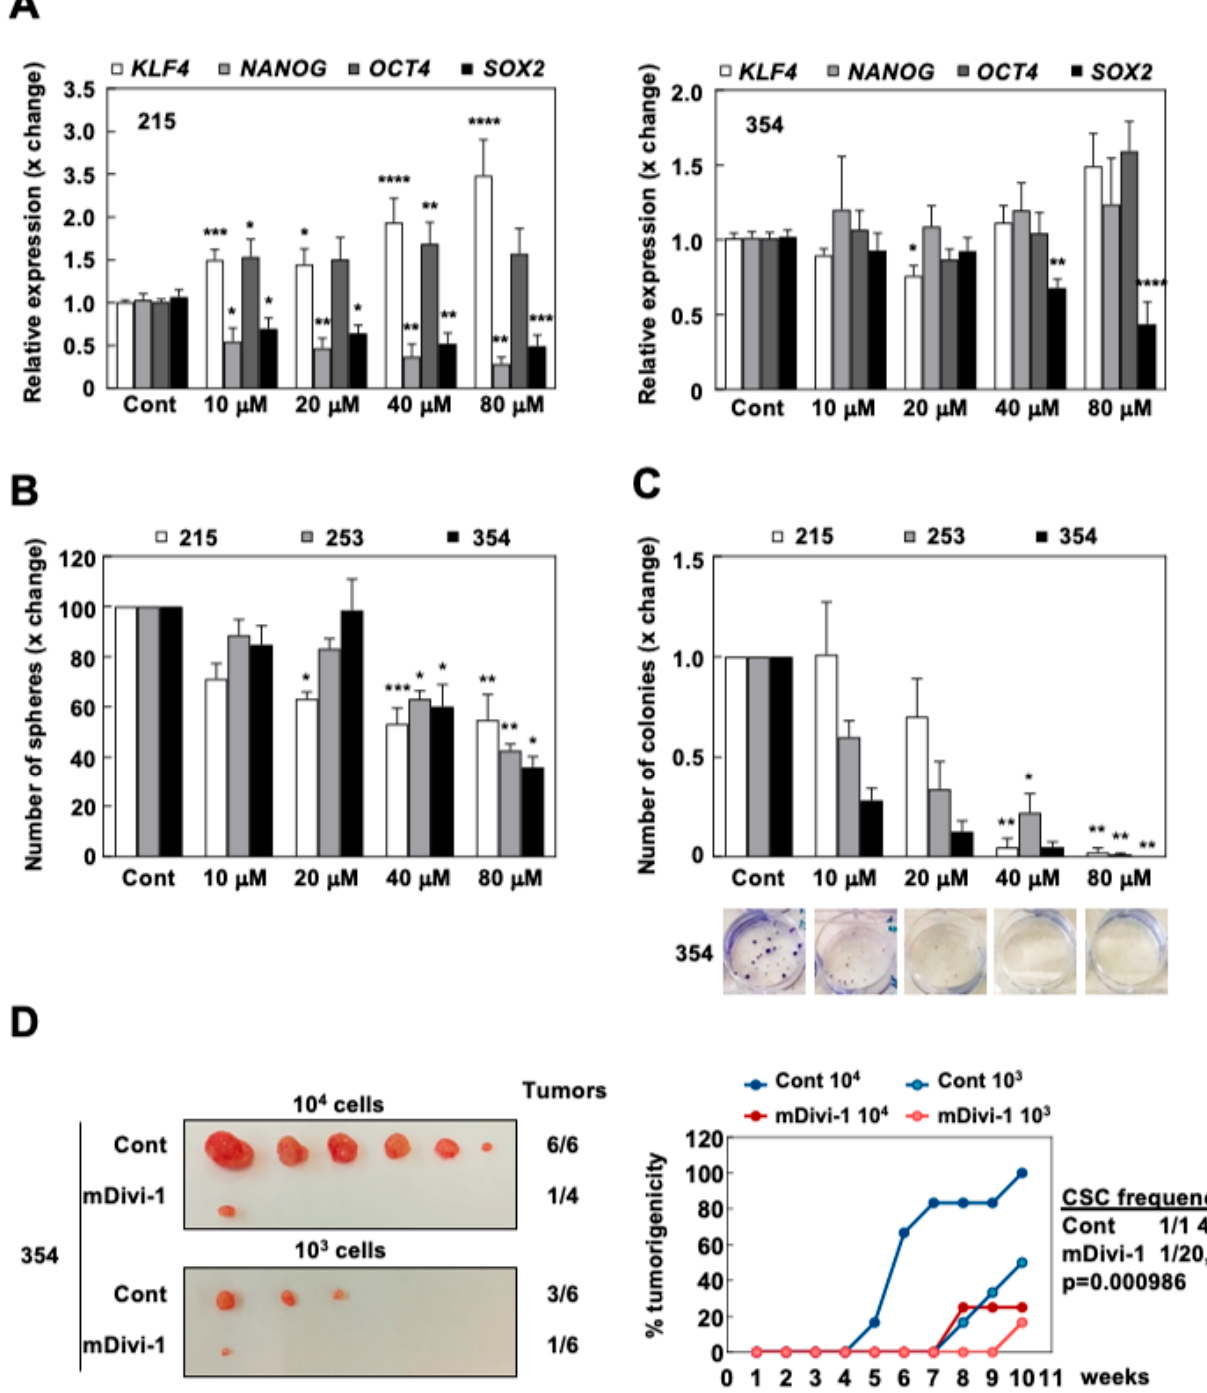
Figure 5. mDivi-1 treatment inhibits self-renewal and in vivo tumorigenicity. ( A ) Relative pluripotency genes expression in 215 and 354 cells treated with 40 µ M mDivi-1 for 72 h ( n = 5–7). ( B ) Number of spheres formed after seven days with or without mDivi-1 treatment ( n = 2–6). ( C ) Colony formation during 21 days with or without mDivi-1. Upper panel, quantification. Lower panel, representative images for 253 cells ( n = 3–6). ( D ) In vivo extreme limiting dilution assay (ELDA). Subcutaneous injection of 10 3 or 10 4 354 cells pretreated for 72 h with 40 µ M of mDivi-1. Left, images of the tumors obtained after 10 weeks. Right, percentage of tumorigenicity over time for each group, allowing for CSC frequency (1 CSC/x total cancer cells) estimation ( n = 6 tumors per group). Data shown in the figure represent averages ± S.E.M. * p < 0.05, ** p < 0.01, *** p < 0.001, **** p < 0.0001; Kruskal–Wallis with Dunn’s post-test. Controls set as 1 or 100% for fold